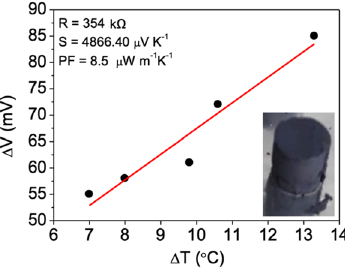
Fig. 7 Thermo-voltage vs. temperature plot measured from a bulk Mg 2 Si piece made with PVDF in DMF solution